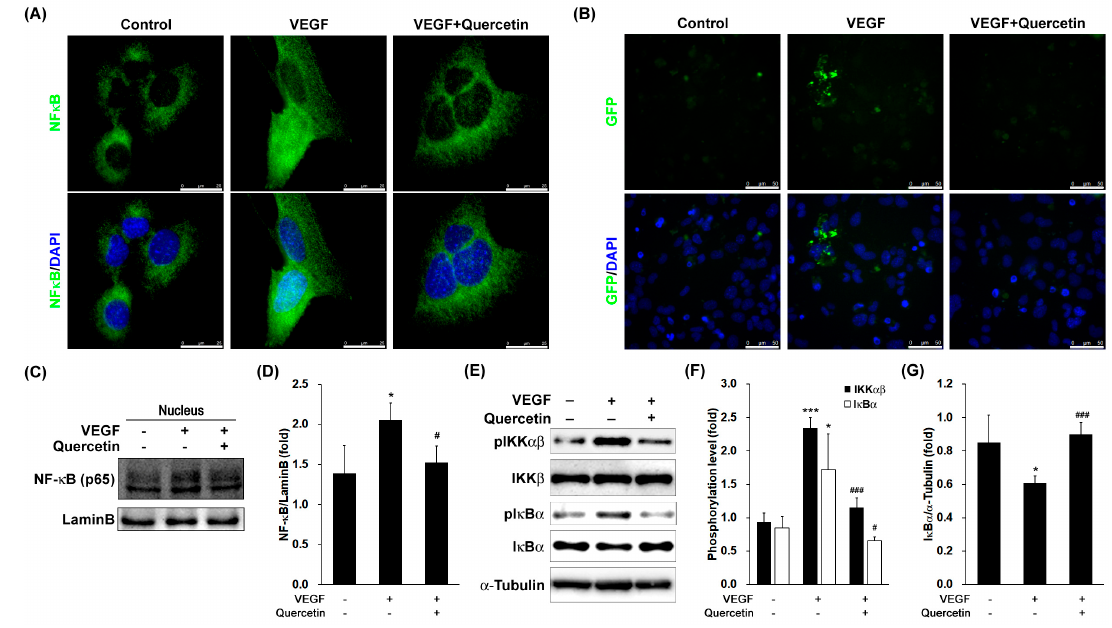
Figure 6. Effect of quercetin on activation of NF- κ B in 661W cells. ( A ) Cells were treated with VEGF (20 ng/mL) in the absence or presence of quercetin (0.1 µM) for 1 h. Cells were prepared for fluorescence microscopy analysis. Scale bar means 25 µm; ( B ) cells were co-transfected with 1 µg of NF- κ B promoter-containing GFP along with 20 ng of control pRL-TK DNA for 40 h. Transfected cells were treated with VEGF (20 ng/mL) in the absence or presence of quercetin (0.1 µM) for 6 h. Cells stained by DAPI were prepared for fluorescence microscopy analysis. Scale bar means 50 µm; ( C ) cells were treated with VEGF (20 ng/mL) in the absence or presence of quercetin (0.1 µM) for 1 h. After cell fractionation, nuclear translocation of NF- κ B were determined by a immunoblot analysis; ( D ) Densitometry quantification of protein expression was measured by ImageJ. Data are the means ± SDs of three independent experiments. * p < 0.05 indicates significant difference compared to the non-treated control group. # p < 0.05 indicates significant difference compared to the VEGF-only treated group; ( E ) cells were treated with VEGF (20 ng/mL) in the absence or presence of quercetin (0.1 µM) for 1 h. Phosphorylation level of IKK αβ and I κ B α were determined by a immunoblot analysis. ( F , G ) Densitometry quantifications of phosphorylation levels of IKK αβ (F) and I κ B α (G) were measured by ImageJ. Data are the means ± SDs of three independent experiments. * p < 0.05 and *** p < 0.001 indicate significant differences compared to the non-treated control group. # p < 0.05 and ### p < 0.001 indicate significant differences compared to the VEGF-only treated group.